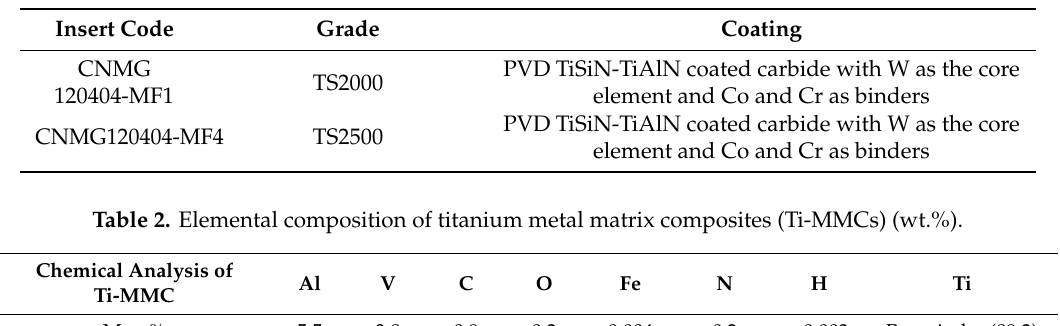
Table 1. The specifications of the inserts used.